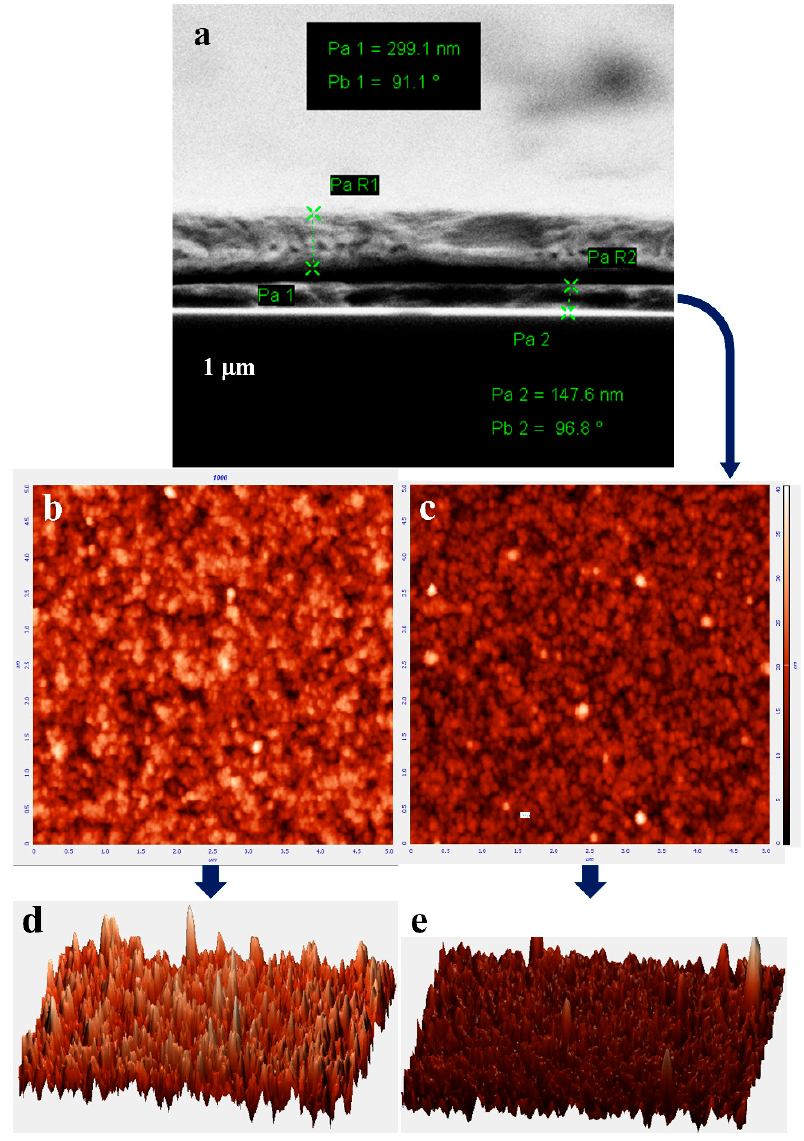
Figure 4. ( a ) A cross sectional SEM image of the hybrid solar cell device, ( b ) showing the AFM topographic image of the PEDOT: PSS film with 3wt % EG and ( c ) 7 wt % of EG on the Planar Si substrate; ( d ) and ( e ) illustrate the AFM 3D topography of the PEDOT: PSS films.